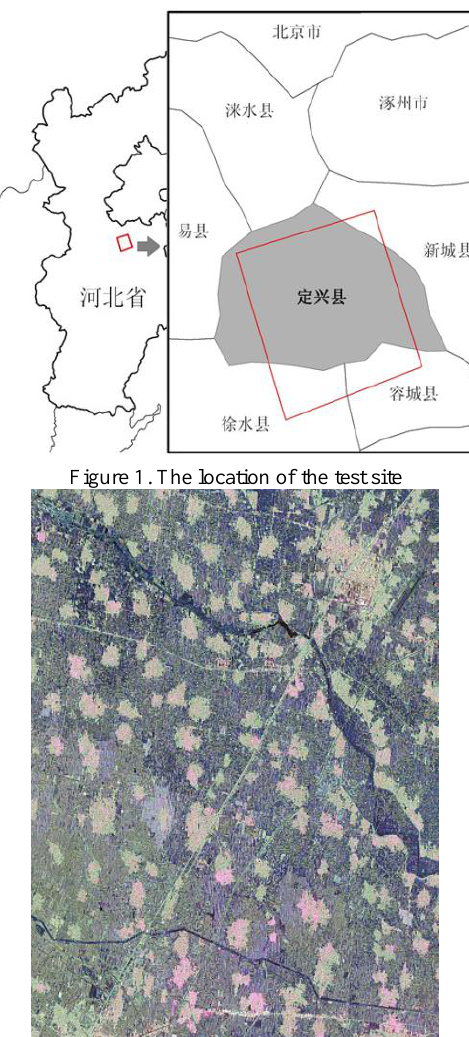
Figure 2. The PauliRGB image of the study